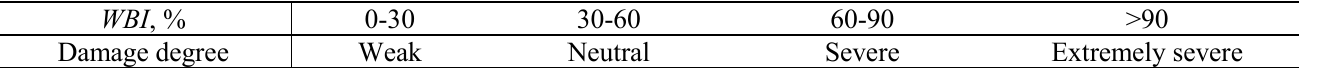
Table 1—Criterion for damage degree of water